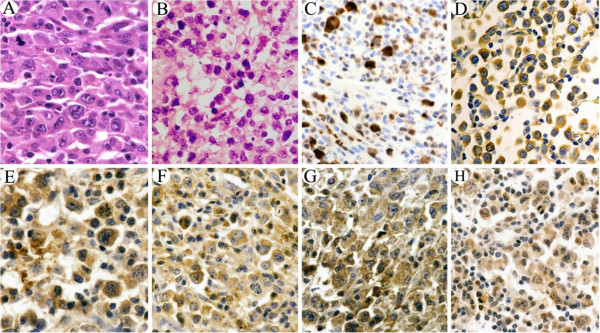
Histology and immunohistochemistry (IHC) of ALCL tumor samples. (A, B) Histology of ALCL tumor samples (HE staining). (A) The classic type of ALCL. The tumor cells are large with abundant cytoplasm and manifest prominent nucleoli with an eccentrically located and pleomorphic nucleus of kidney-shape. (B) ALCL of small cell type. The tumor cells are small in size, with abundant cytoplasm and prominent nucleoli. (C to H) IHC staining of ALCL tumor samples (EnVision staining). Expression of ALK, p-AKT, p-mTOR, p-4E-BP1, and p-p70S6K eIF4E was assessed. (C, D) IHC staining with ALK1 antibody. (C) The tumor cells show cytoplasmic and nuclear staining. (D) The tumor cells manifest cytoplasmic staining only. (E) IHC staining with Thr308p-AKT antibody. The tumor cells show cytoplasmic and nuclear staining. (F) IHC staining with Ser2448p-mTOR antibody. The tumor cells show cytoplasmic staining. (G) IHC staining with Thr70p-4E-BP1 antibody. The tumor cells show cytoplasmic staining. (H) IHC staining with Thr421p-p70S6K antibody. The tumor cells show cytoplasmic staining. All images were captured at 400× magnification.